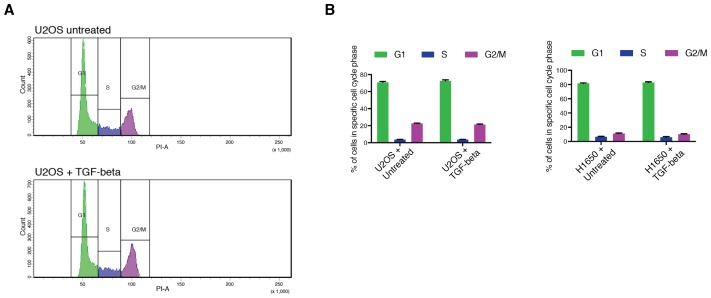
Exposure to TGF-β does not alter the cell cycle distribution in cancer cell lines.(A) TGF-β treatment does not alter the cell cycle distribution in U2OS cells. The histograms represent U2OS cell cycle distribution without or with TGF-β (1 ng/ml of each of TGF-β1 and TGF-β2, 9 hr). 10,000 cells were analyzed by FACS for each replicate of each sample. (B) Quantification of cell cycle distribution from U2OS and H1650 cells upon 9 hr treatment with TGF-β (1 ng/ml of each of TGF-β1 and TGF-β2). Each bar represents the mean ± SD of three replicates from two independent experiments.